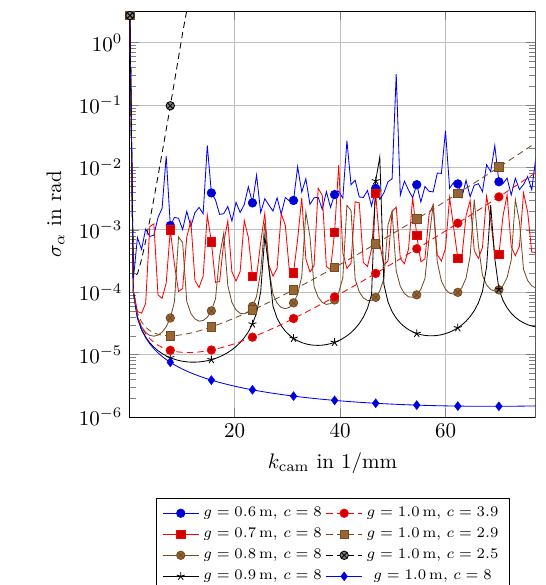
Figure 13. Deflectometric measurement uncertainty of the surface normal for several focus distances and surface MTF parameters.